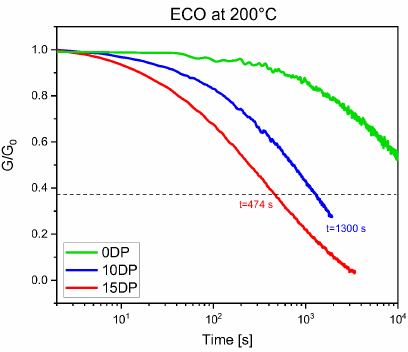
Figure 6. Stress relaxation of ECO with no catalyst, 10 phr DP, and 15 phr DP. The test was done at 200 ◦ C with a constant strain of